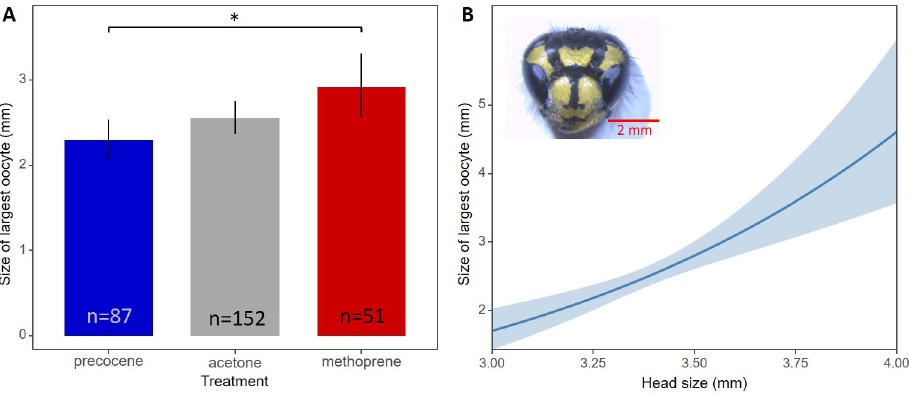
Fig 2. (A) Oocyte size is largest in methoprene treatment, followed by acetone and precocene. 1-tailed pairwise contrasts shows a significant difference between all treatments size. The control treatment acetone did not differ from both the methoprene (t ratio = -1.76, p = 0.081) and precocene (t ratio = 1.68, p = 0.097) treatments, but between methoprene and precocene treatments the biggest oocyte size differs significantly (t ratio = 2.64, p = 0.013). (B) Effect plot of model fitted based on the measurements of the head width of